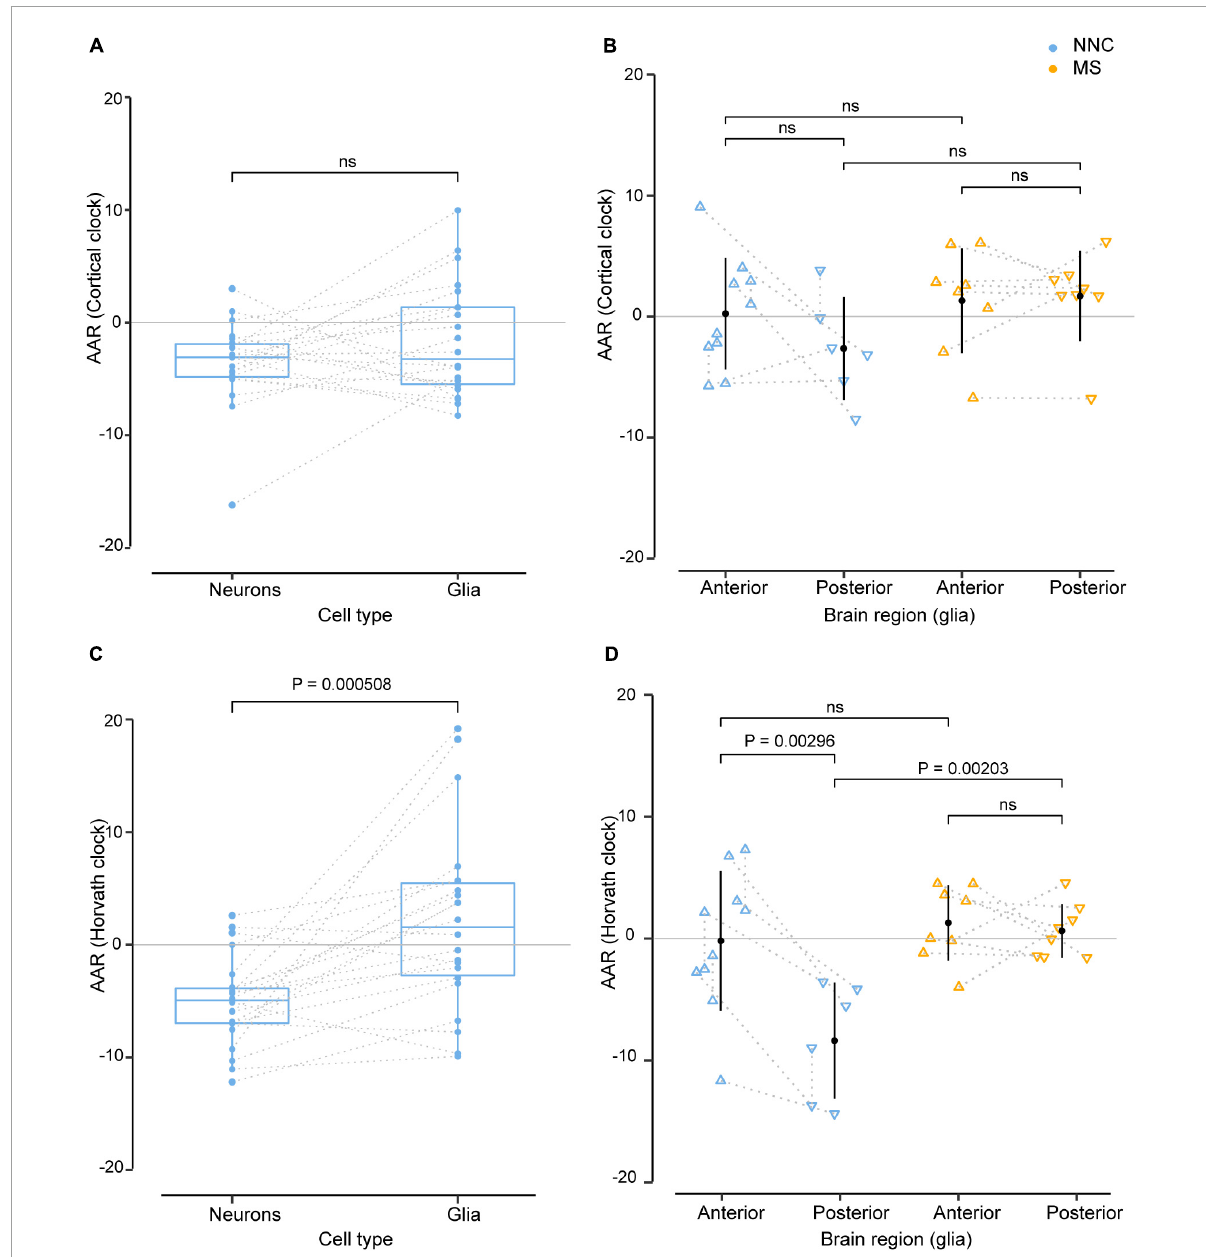
FIGURE2 Effect of cell type and sample location from the same donors in the estimation of DNAm age. Age acceleration residuals (AAR) in glial cells and neurons sorted from the same control donors [left panels (A,C) ] and in glial cells located in anterior and posterior regions of the brain of the same MS patients and controls [right panels (B,D) ] estimated using the Cortical clock (upper panels) and Horvath’s clock (lower panels). Normality was tested with the Shapiro–Wilk test. (A,C) Sample differences were compared with a paired two-sample t -test. (B,D) Equal variances were tested with Bartlett’s test and sample means compared with a Tukey HSD test, correcting P-values for multiple testing with the single-step method (B,D) . The significance level for all tests was set to P = 0.05. Glia and neuron data from the same donors (A,C) were taken from Kozlenkov et al. (2014), Gasparoni et al. (2018), and anterior and posterior data in glia from the same donors [right panels (B,D) ] were taken from Kular et al. (2022). The dotted line denotes the same donor. MS, multiple sclerosis; NNC, non-neurological control; ns, not